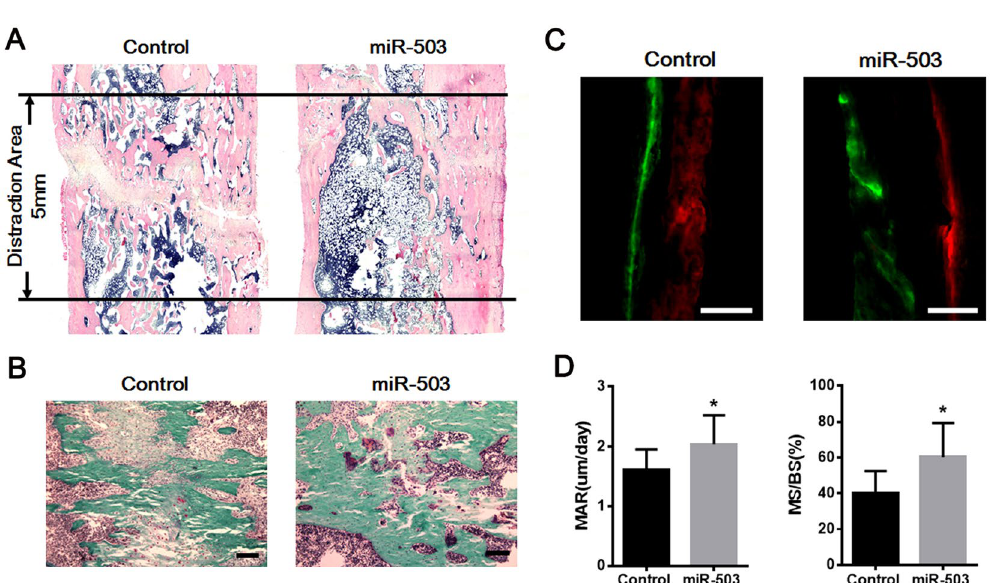
Figure 7. Bone tissue regeneration is accelerated by overexpression miR-503 therapy in DO animal model. ( A ) From HE staining of lengthened tibia in sagittal section, most of the regenerated bone tissues were mature in distraction gap in miR-503 overexpression group, while lots of cartilaginous callus still could be found in distracted gap in control group. ( B ) From Goldner’s trichrome staining, result showed that bone remodeling was vigorous in miR-503 overexpression group while lots of cartilage cells and fiber tissues still could be found in the distraction area. (Scale Bar = 150 μ m). ( C ) Calcein (green) and Xylenol (orange) were subcutaneously injected into the rats at day 15 and day 43 separately. Vertical interval of the lines represented the amount of newly formed bone between the injection interphase. Result indicated miR-503 overexpression could promote mineralization of newly formed bone. (Scale Bar = 100 μ m). ( D ) The dynamic histomorphometric parameters including MAR and MS/BS were found higher in miR-503 overexpression group than that in control group. (n = 5 each group, * P <